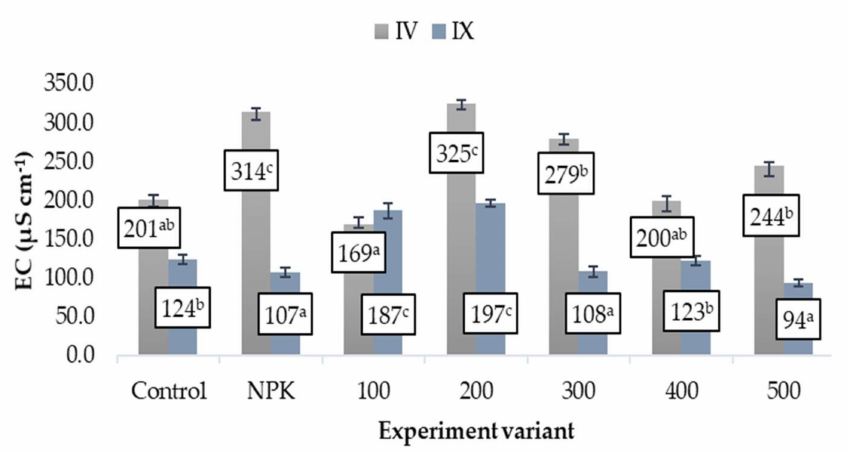
Figure 4. Changes in the salinity of the chernozem soil in the 0–5 cm layer in IV (April) and IX (September) 2021 after the application of biomass combustion ashes (mean ± SD). Treatments not sharing the same letter(s) are statistically significant at p < 0.05 (Tukey’s